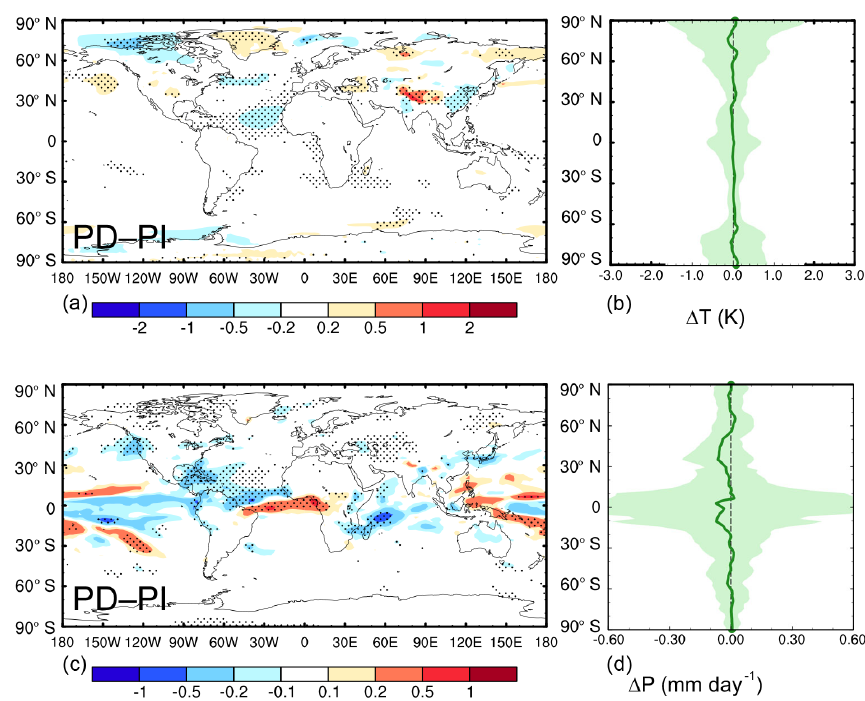
Figure 10. Spatial distribution (a, c) and zonal mean (b, d) of differences in annual mean surface temperature (K, a , b ) and total precipitation rate (mmday − 1 , c , d ) between PD and PI. The dotted areas in (a, c) indicate statistical significance with 95% confidence from a two-tailed Student’s t